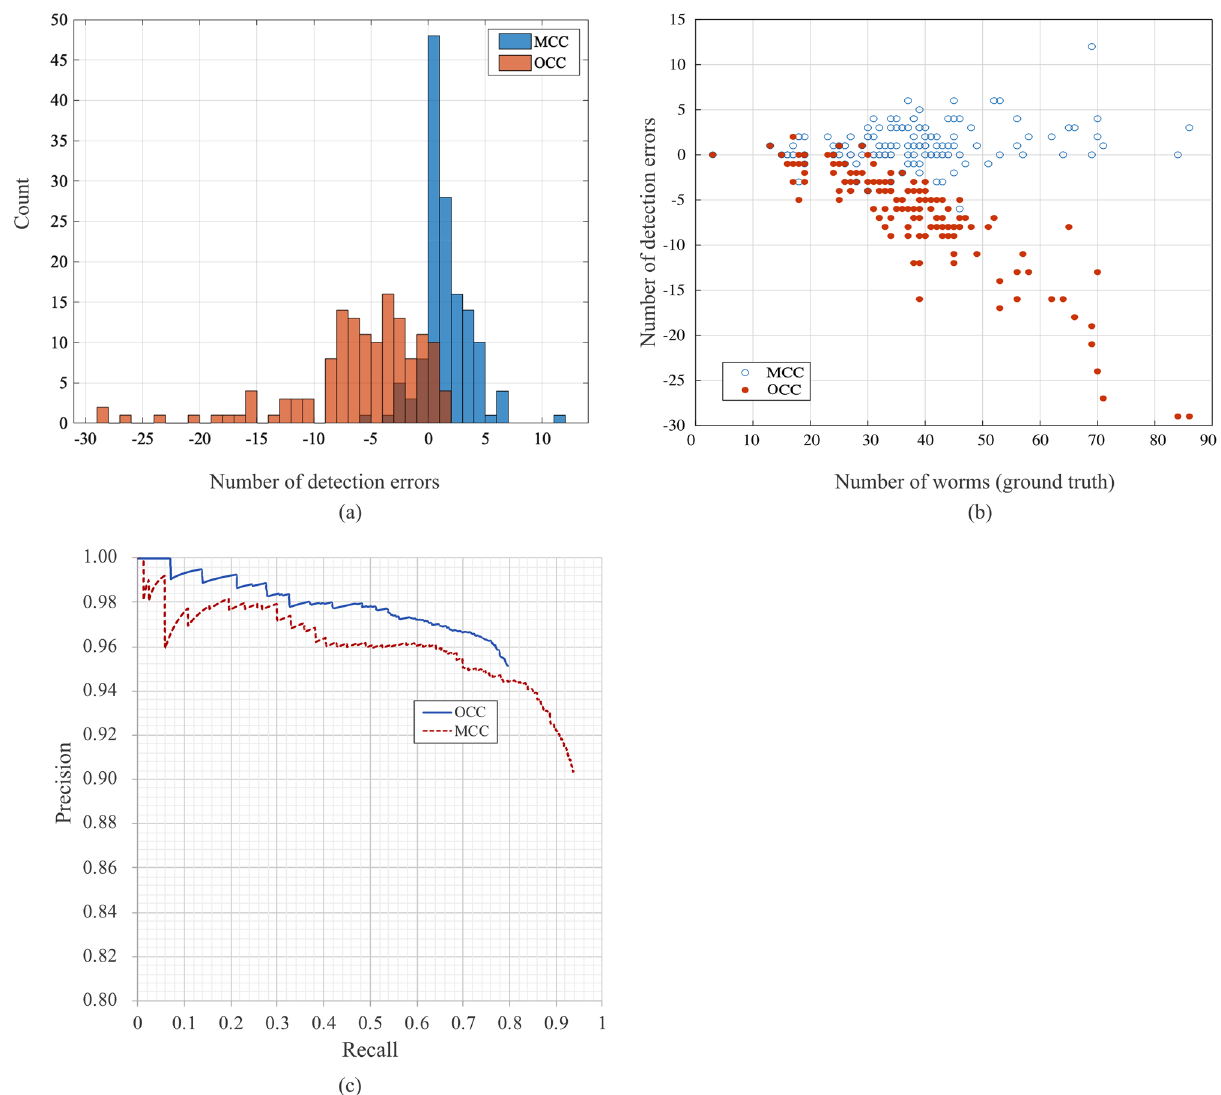
Figure 2. ( a ) Histogram for the number of detection errors in OCC and MCC. ( b ) Scatter plot shows the number of worms (ground truth) and the number of detection errors for OCC and MCC. ( c ) Precision-recall curve for the OCC (solid line) and MCC (dotted line). IoU threshold is 0.5. Abbreviations: OCC = one-class classification, MCC = multi-class classification, IoU = Intersection over union .